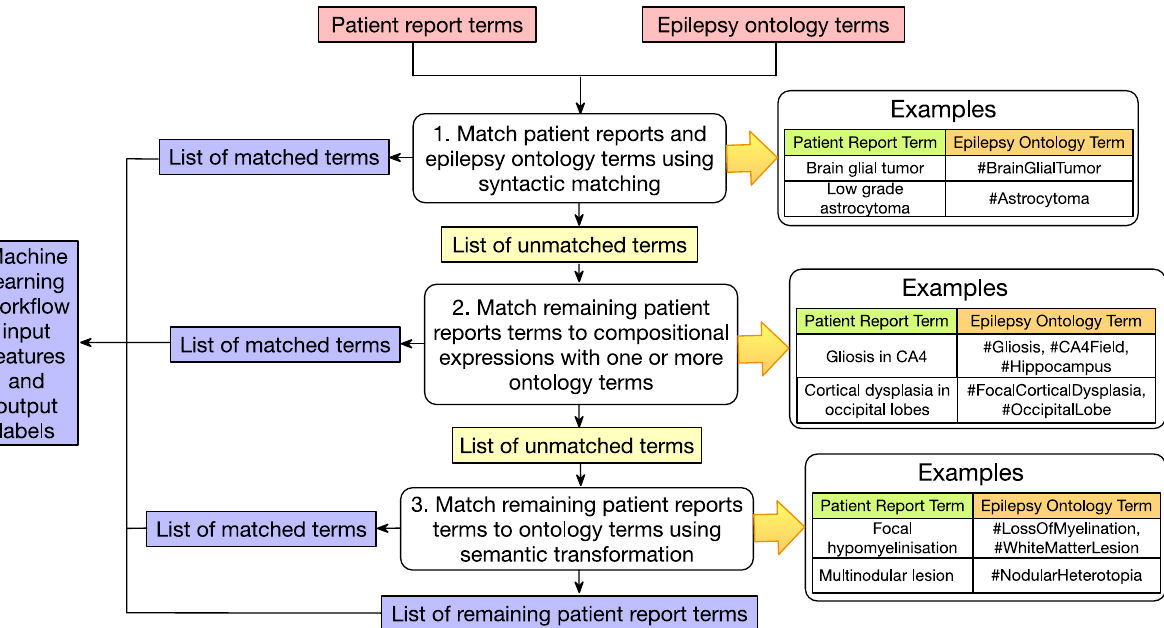
Figure 3. Feature engineering workflow used to map terms in patient reports to epilepsy ontology with a three- step approach. The first step uses syntactic matching, followed by mapping a composition of ontology terms, and finally semantic transformation. All the mappings were manually reviewed. The final list of terms after the three- step matching process is used as input features and output labels to the machine learning models.